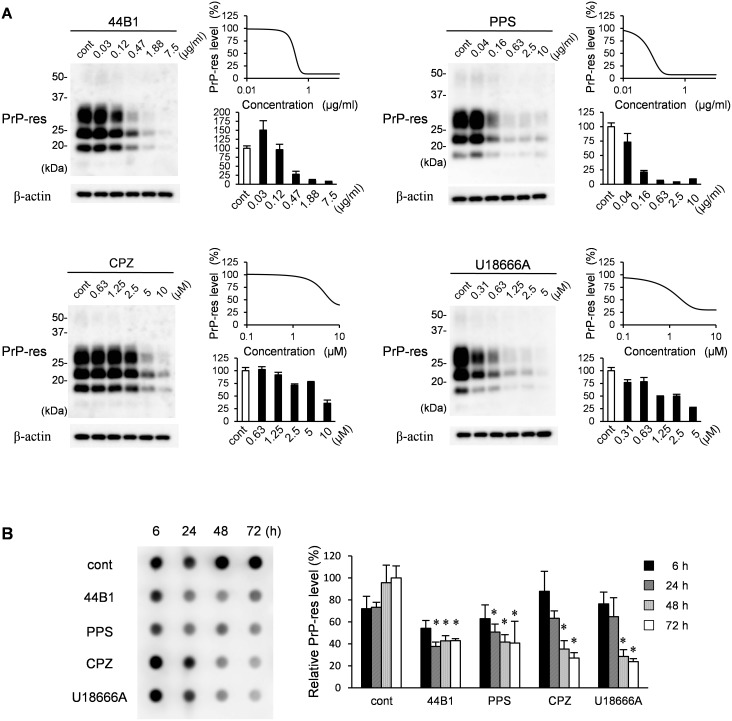
Influence of anti-prion compounds on the amount of PrP-res.(A) ScN2a-3-22L cells grown on 12-well plates were cultured in the presence or absence of mAb 44B1, PPS, CPZ, or U18666A at the indicated concentration for 72 h. The samples were subjected to immunoblotting and dot-blotting for PrP-res detection or β-actin detection for endogenous control. Representative blots for each compound are shown on the left. The graph on the right shows PrP-res levels relative to the control samples. The means and standard deviations (SDs) of four independent experiments (PrP-res was detected by dot-blotting) are indicated. Graphs on the upper right show the logistic curve fitted to the data of PrP-res levels by dot-blotting (B) ScN2a-3-22L cells were cultured with anti-prion compounds at the EC65 (mAb 44B1, 0.4 µg/ml; PPS, 0.1 µg/ml; CPZ, 10 µM; U18666A, 5 µM) for the indicated time and subjected to dot-blotting for PrP-res. Representative dot-blotting is shown on the left, and the graph on the right shows the levels of PrP-res relative to the samples from ScN2a-3-22L cells cultured without anti-prion compounds for 72 h. The means and SDs of four independent experiments are depicted. Asterisks indicate a significant difference compared with the control at the same time point (Student’s t-test, p<0.05).